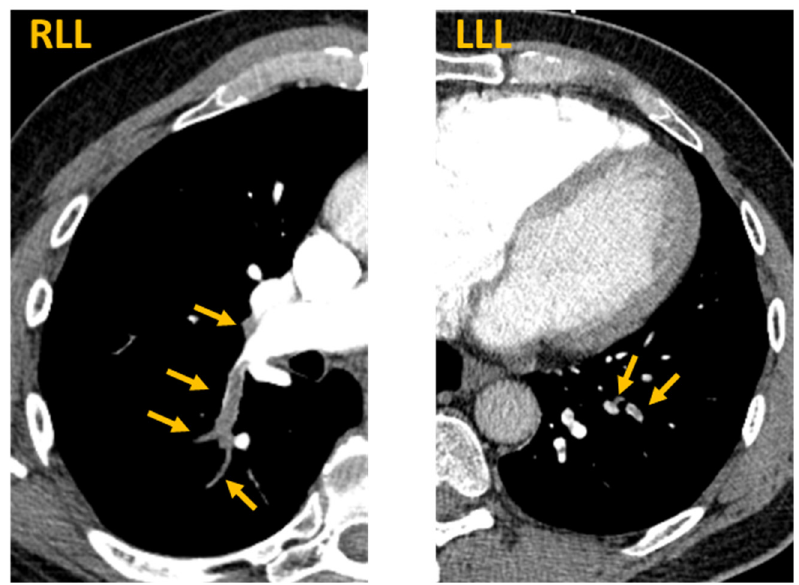
Figure 1. Acute pulmonary emboli after SARS-CoV-2 mRNA vaccination. CT PE protocol axial images demonstrate bilateral segmental and subsegmental pulmonary emboli. Arrows indicate contrast filling defects at locations of pulmonary emboli. RLL = right lower lobe. LLL = left lower lobe.